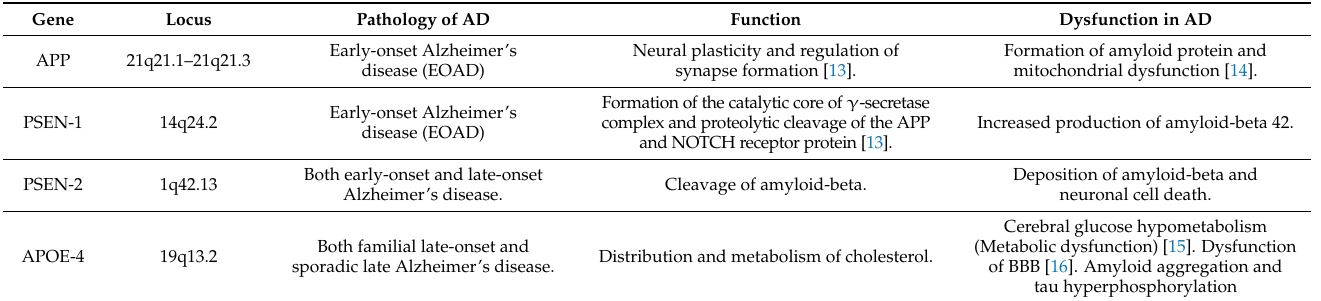
Table 1. Summary of major genes responsible for Alzheimer’s disease.